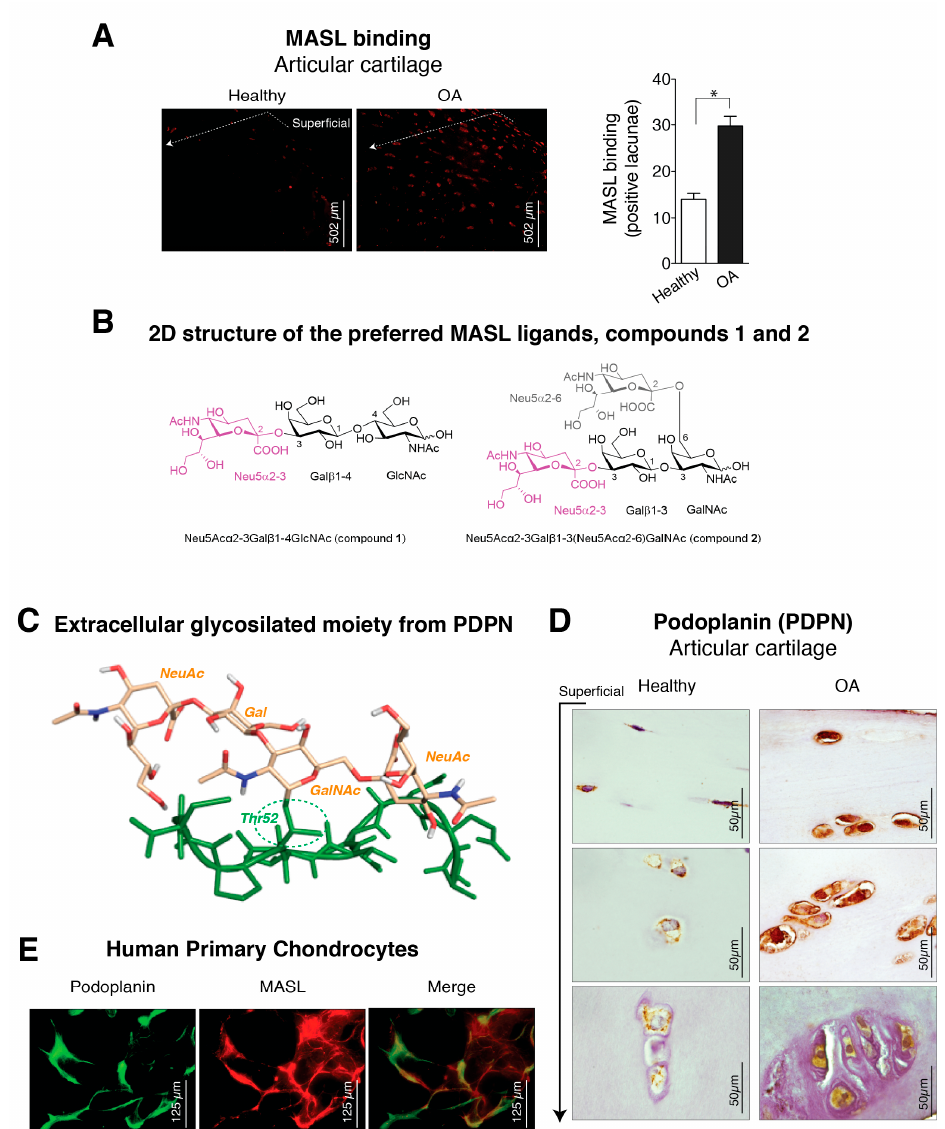
Figure 1. Expression of α -2,3-sialylated glycoproteins, represented by podoplanin (PDPN), is induced in arthritic chondrocytes. ( A ) Maackia amurensis seed lectin (MASL) conjugated to HiLyte Fluor TR (red) was used to detect α -2,3-sialylated glycoproteins in cartilage sections from healthy donors (n = 4) and patients with grade II osteoarthritis (OA) (n = 4). The graph represents the number of positive lacunae (mean ± SEM), n = 4, * p < 0.05, Mann–Whitney test. Healthy donors are represented by white bar and OA patients in black; ( B ) 2D structure of the preferred Maackia amurensis ligands. Left: sialyllactosamine (compound 1 ), preferred by leucoagglutinin (MAL). Right: tetrasaccharide (compound 2 ), preferred by haemagglutinin (MAH). Both sugars contain α -2,3 or / and α -2,6 sialyl (Neu5Ac) linkages (in magenta Neu5Ac α 2–3 and in grey Neu5Ac α 2–6); ( C ) 3D structure of the extracellular glycosylated moiety of PDPN adapted from PDBID 3WSR. The peptidic portion is shown in green. Thr52 is O-glycosylated with Neu5Ac α (2–3)Gal β -(1–3)[Neu5Ac α (2–6)]GalNAc, which is shown in beige; ( D ) PDPN protein levels were detected by IHC analysis of cartilage from healthy donors (n = 4) and grade II patients with OA (n = 9). See Figure A1. Arrow indicates cartilage sections extending from the superficial, adjacent to the synovial fluid, into the intermediate and deep zones; ( E ) Primary chondrocytes from healthy donors and grade II OA patients were incubated with HiLyte Fluor TR-labelled MASL to detect α -2,3-sialylated glycoproteins (red) and with monoclonal antibody to detect PDPN by immunofluorescence (green). Colocalization of MASL and PDPN was evident in the merged images